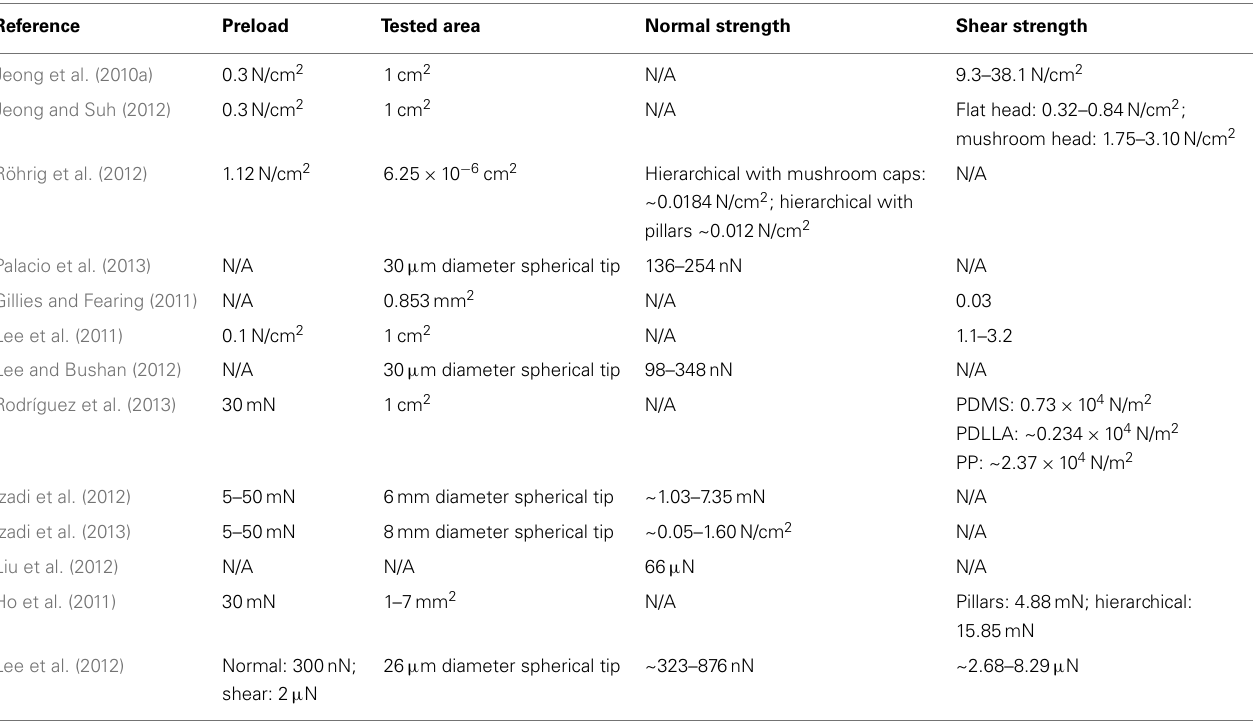
Table 3 | Summary of adhesion results